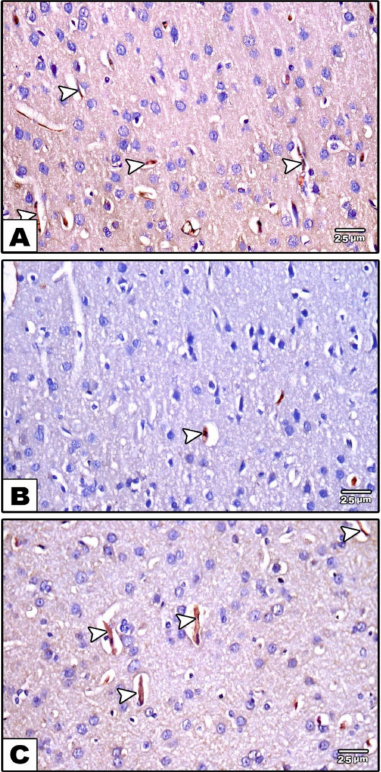
Figure 6. Photomicrographs of sections in the cerebral cortex immunohistochemically stained with eNOS. ( A ): In the control group, strong positive eNOS immunoreactivity is seen in the endothe- lial lining of the blood vessels (arrows) ( B ): In the reserpine-treated group, week positive eNOS immunoreactivity (arrows) can be observed ( C ): In the fisetin-treated group, mild positive eNOS immunoreactivity in the endothelial lining of blood vessels (arrows) can be